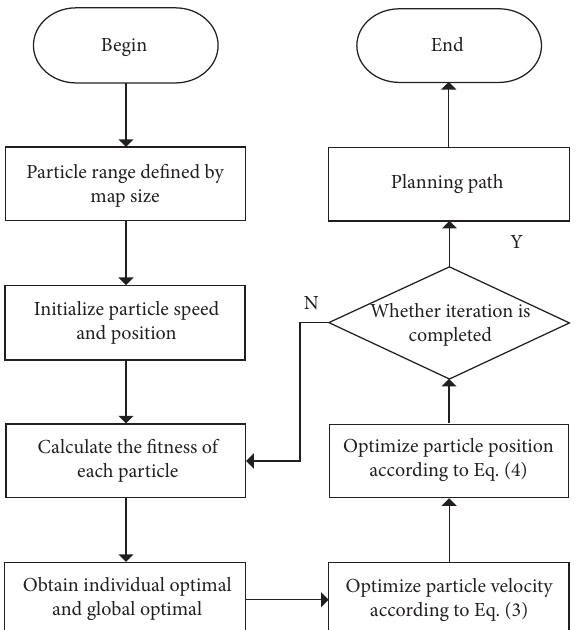
Optimize particle velocity according to Eq.